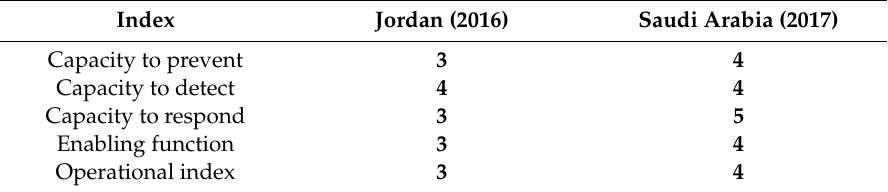
Table 2. Joint External Evaluation (JEE) mission report scores across five capacity indices for Jordan and Saudi